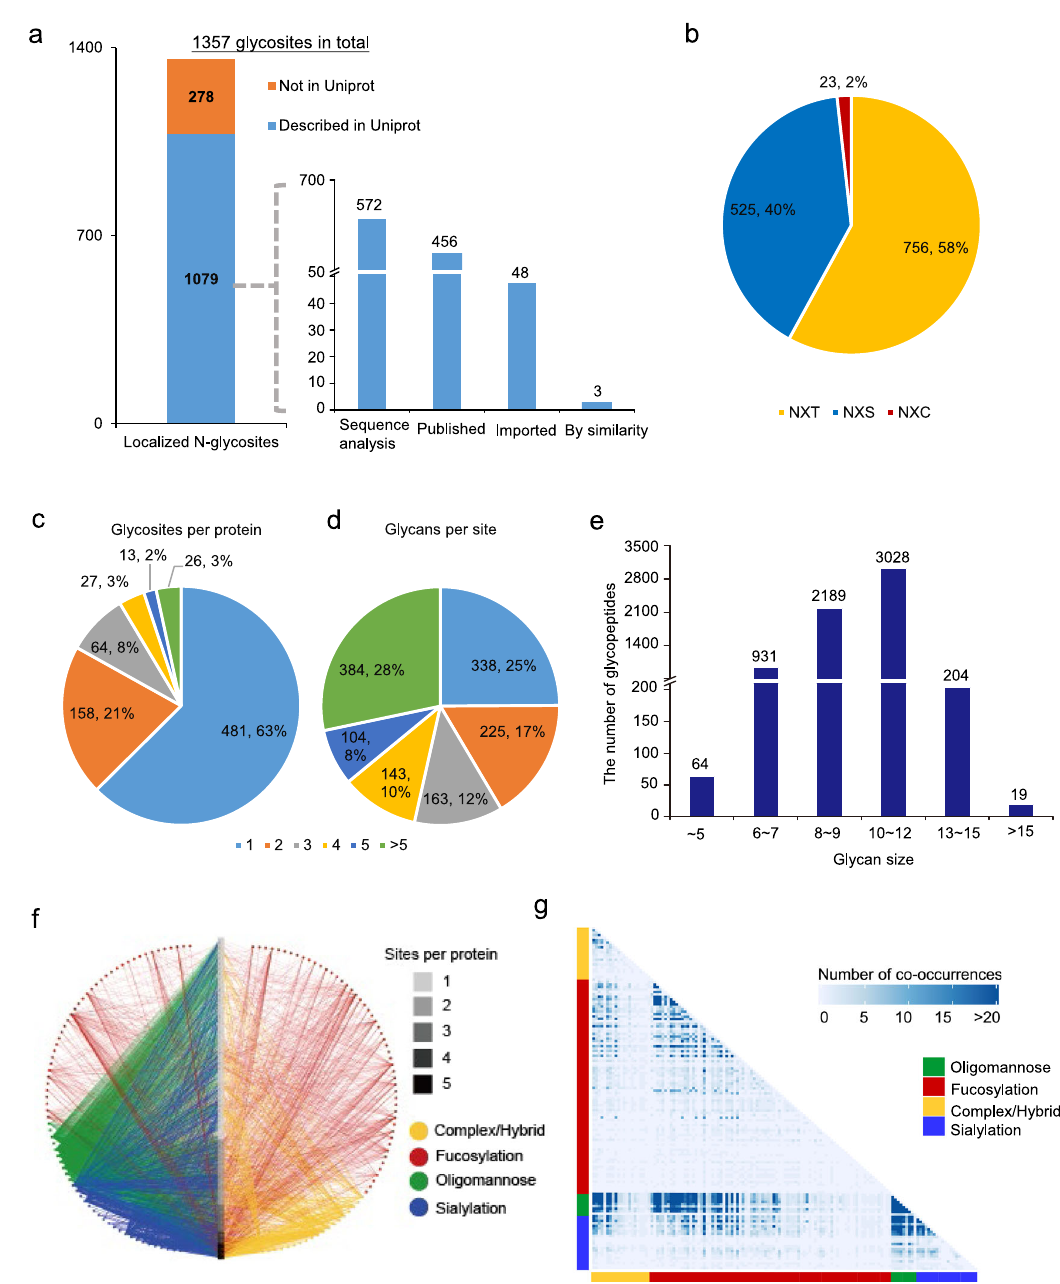
Fig. 5 | Characteristics of site-speci fi c N -glycans quanti fi ed in HCC cell lines. a The status of quanti fi ed glycosites recorded in the UniProt